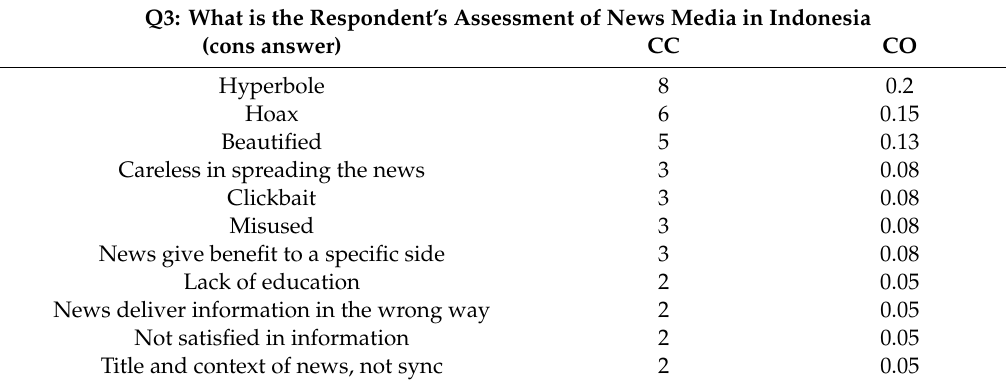
Table 16. Co-occurrences of Question 3, cons.